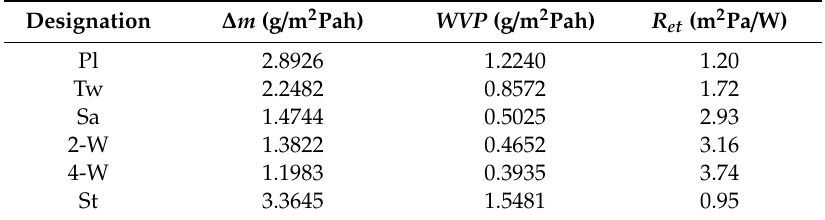
Table 4. Results of fabric samples water vapor permeability and resistance.